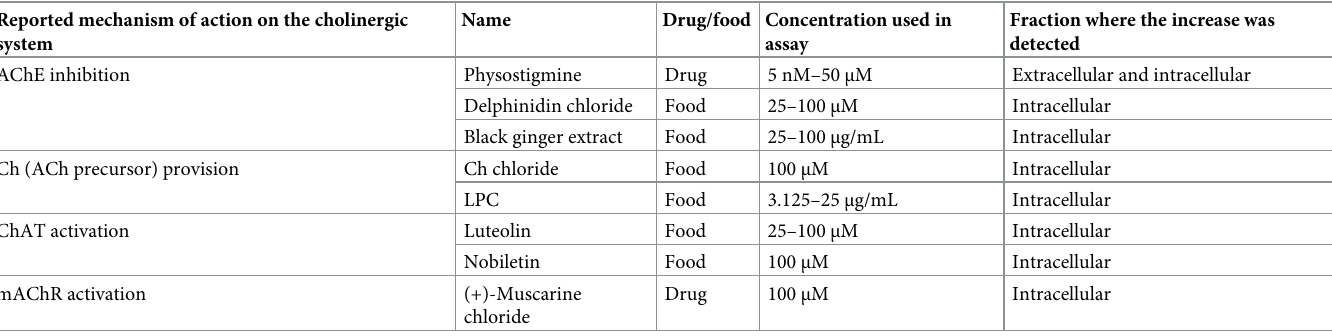
Table 5. Drug compounds and food constituents that increased extracellular and/or intracellular ACh levels in our cell-based assay. Reported mechanism of action on the cholinergic system